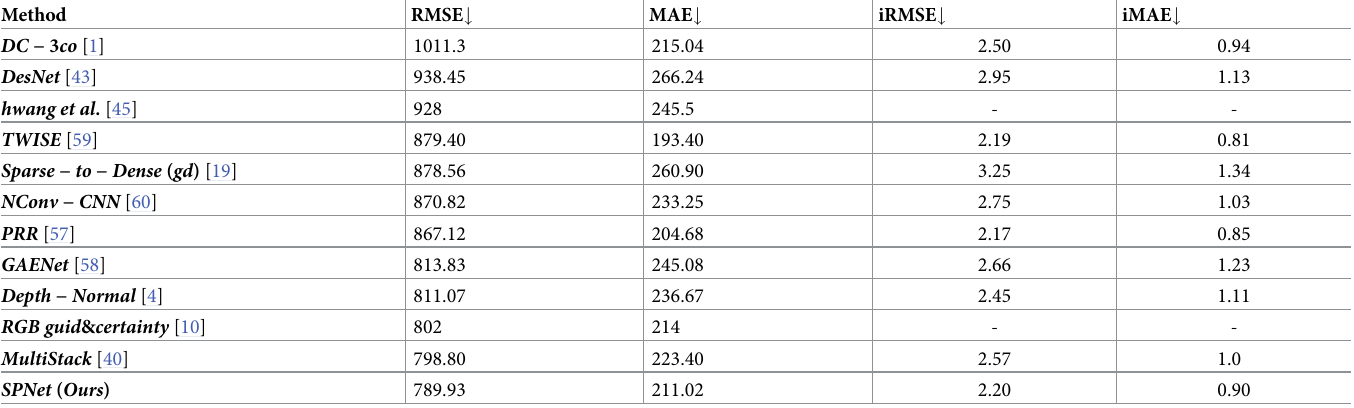
Table 2. Quantitative comparison on KITTI DC validation set.